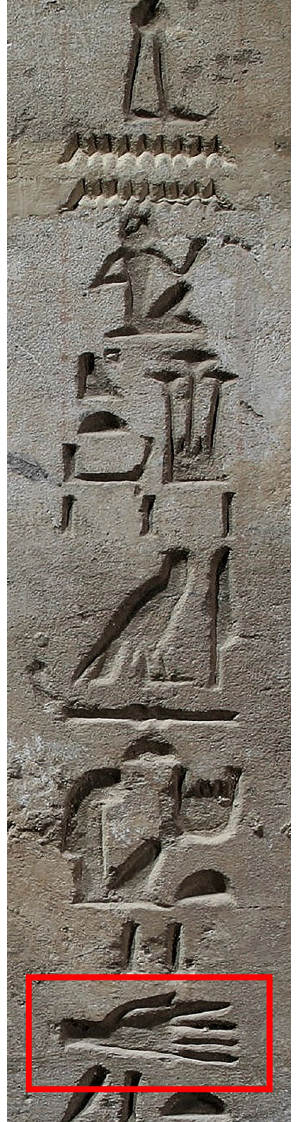
Figure 3. Iconographic evidence of severed hands: inscription in the tomb of Ahmose at El-Kab depicting a very realistic representation of an outstretched palm, showing five spread fingers (Courtesy of William